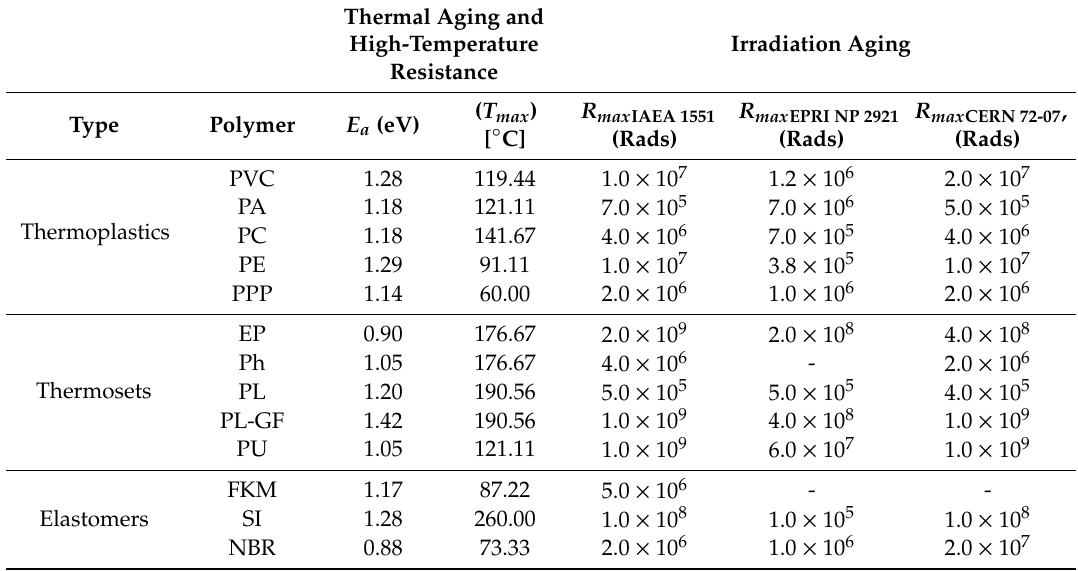
Table 2. Evaluation of parameters of degradation (due to thermal and irradiation conditions) [45–48].